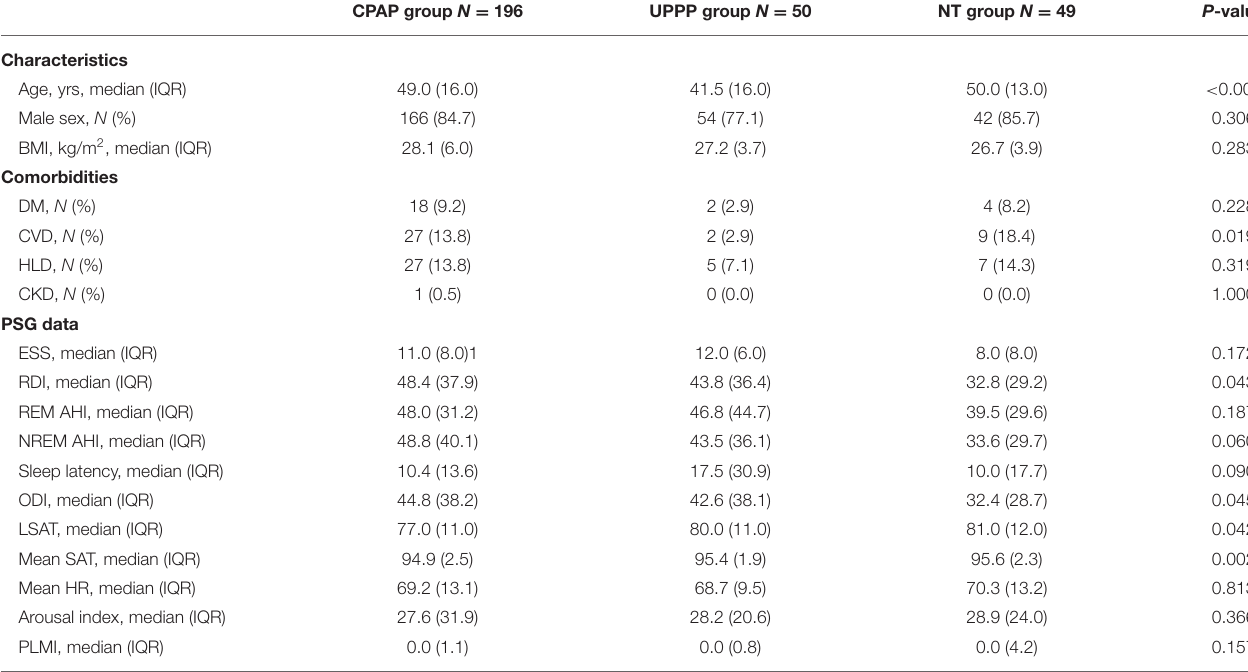
TABLE 1 | Baseline characteristics, comorbidities, PSG data of the study